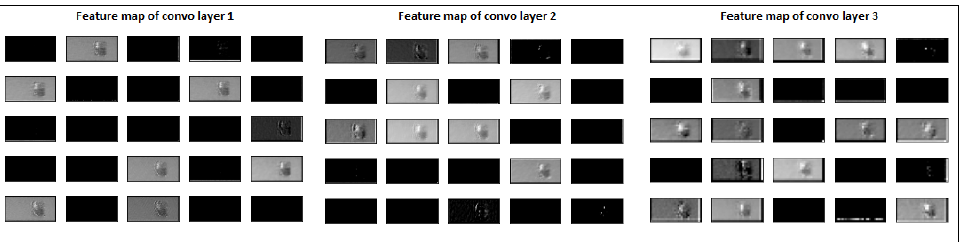
Figure 13. Feature maps of defective layer image 440 after each convolutional layer.